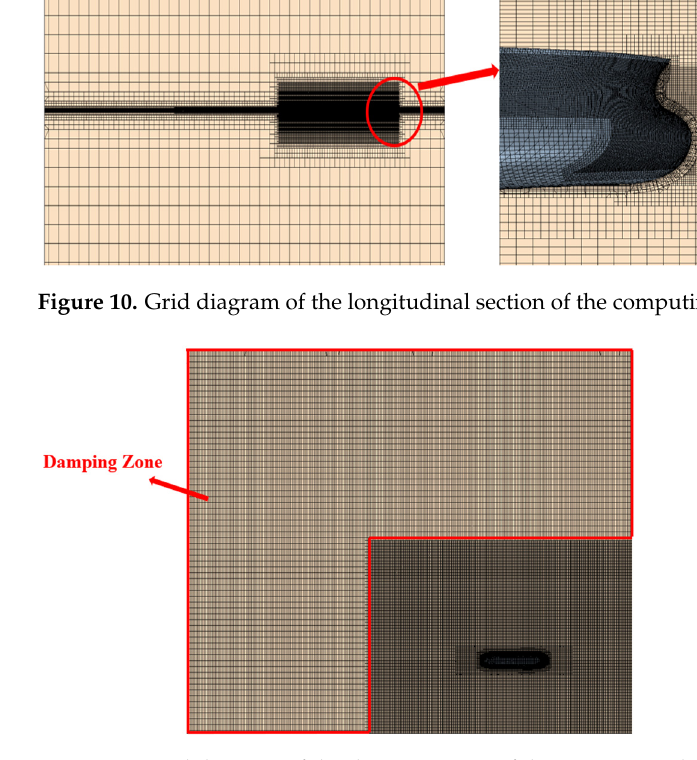
Figure 12. Least squares fitting of the surge, sway, and yaw forces and moment of KVLCC2 ship under H = 0.02 L PP , λ = 1.1 L PP , χ = 120°, β = 0°, and U = 6.0 kn. Figure 13 shows the time history diagram of the surge, sway, and yaw wave drift forces and moment of the KVLCC2 ship under H = 0.02 L PP , λ = 1.1 L PP , χ = 120°, β = 0°, and U = 6.0 kn, which correspond to different grid numbers of the computational domain (4.5 × 10 6 , 5.8 × 10 6 , and 7.5 × 10 6 ), time-step scales (T/450, T/900, and T/1800), and damping zone length (1.5 Lpp, 3.0 Lpp, and 6.0 Lpp), respectively. Compared with different model results, it is clear that the surge, sway, and yaw wave drift force, and moment of the KVLCC2 ship have better convergence. Considering the overall calculation accuracy and efficiency, the grid numbers of the computational domain, time-step scales, and damping zone length are selected as 5.8 × 10 6 , T/900, and 3.0 L PP , respectively.